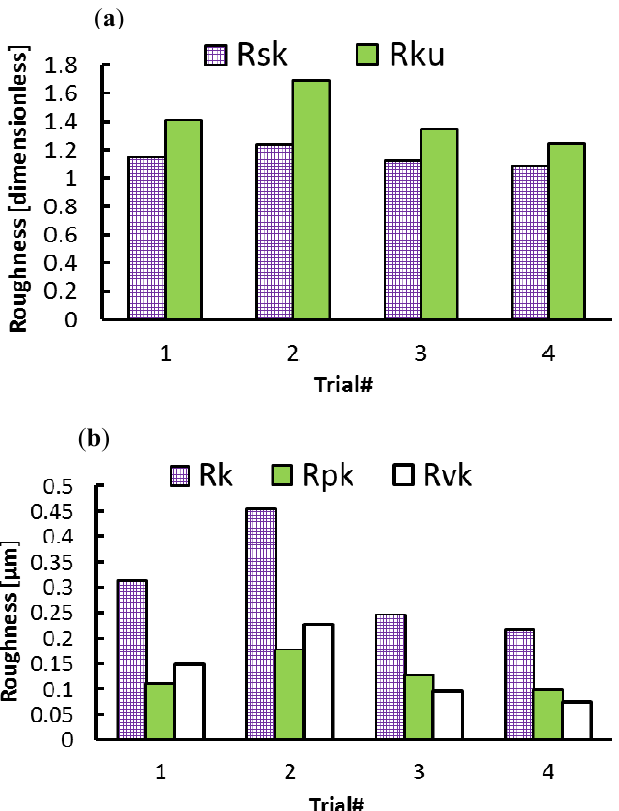
Figure 6. Effect of cutting conditions on amplitude distribution parameters in axial direction: ( a ) dimensionless parameters; ( b ) dimensional